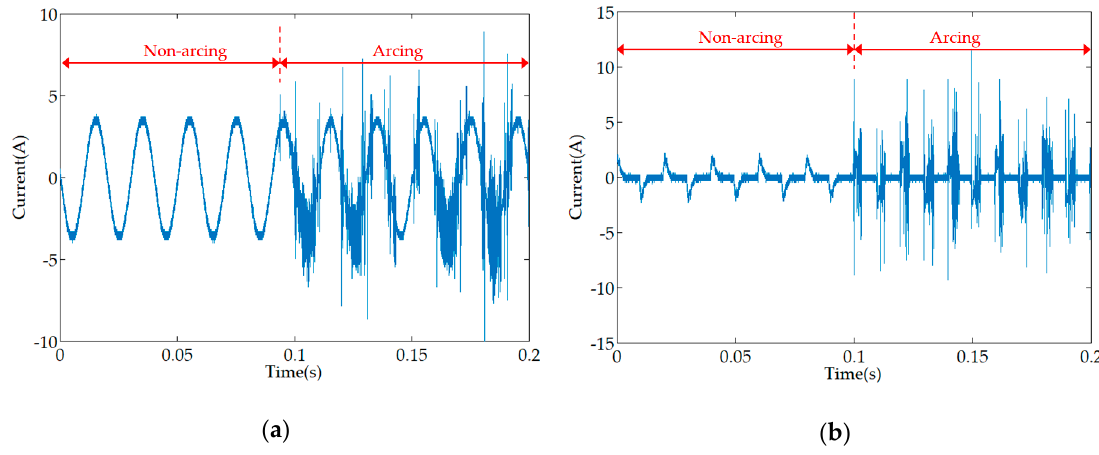
Figure 1. The current waveforms of several loads: ( a ) incandescent lamp; ( b ) energy saving